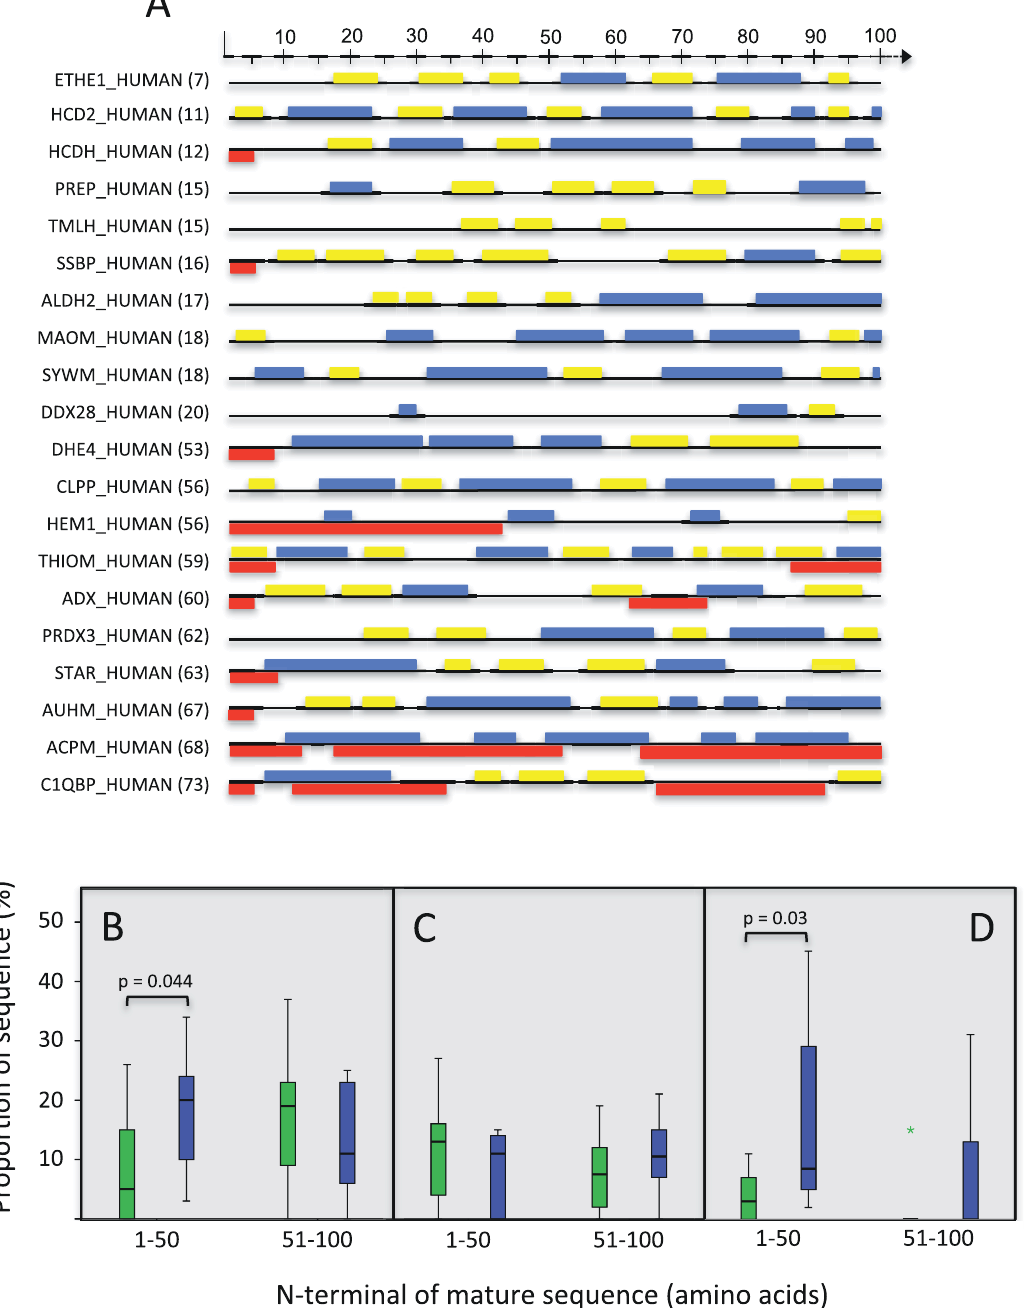
Figure 4. N-terminal secondary structure analysis of H.sapiens mature sequences associated with the ten shortest and ten longest MTSs. (A) Individual sequence IDs are indicated with MTS length in parentheses. Scale bar represents amino acid residue position after the MTS cleavage site. Yellow boxes – alpha helix, Blue boxes – beta sheet, Red boxes – predicted disordered sequence. Figure was adapted from secondary structure predictions of indicated mature sequences generated at www.predictprotein.org. Quantitative analysis of the proportion of predicted alpha helix (B), beta strand (C), and disordered (D) structures in the N-terminal mature sequences of short (green box plots) and long (blue box plots) MTSs for the first and second 50 amino acids of the mature sequence. The distribution of each structural group was analysed using a Kruskal-Wallis test for independent samples.